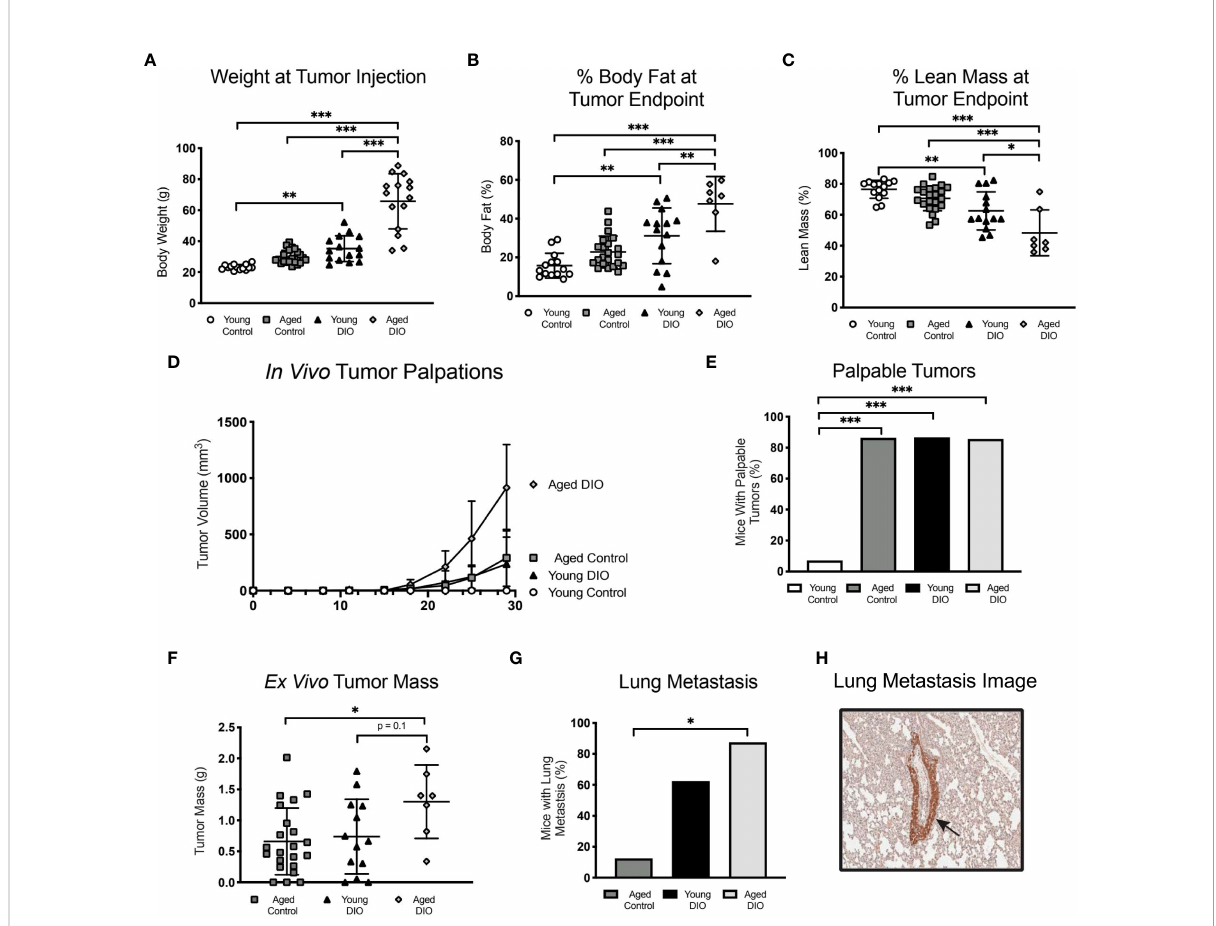
FIGURE 5 Advanced age and DIO exert a combined effect on mammary tumor progression in a E0771 cell transplant model of TNBC. (A) Body weight at tumor inoculation. (B) % body fat mass and (C) % lean mass measured at study endpoint. (D) In vivo tumor volume following E0771 cell injection. (E) Percentage of mice that developed palpable mammary tumors, analyzed using Fisher ’ s exact test. (F) Ex vivo tumor mass. Only one mouse in the young control group developed a tumor, so no data is shown for that group. (G) Percentage of mice that developed at least one metastatic lesion in the lung, statistical difference analyzed using Fisher ’ s exact test. Only one mouse in the young control group developed a primary tumor with no metastatic lesions,so no data is shown for that group. (H) R epresentative image of GFP stained metastatic lesion (arrow). Data presented as mean ± SD. Differences across groups analyzed using one-way ANOVA and Tukey post hoc test, unless otherwise speci fi ed. Asterisks indicate differences in signi fi cance. *p < 0.05, **p < 0.01, ***p <